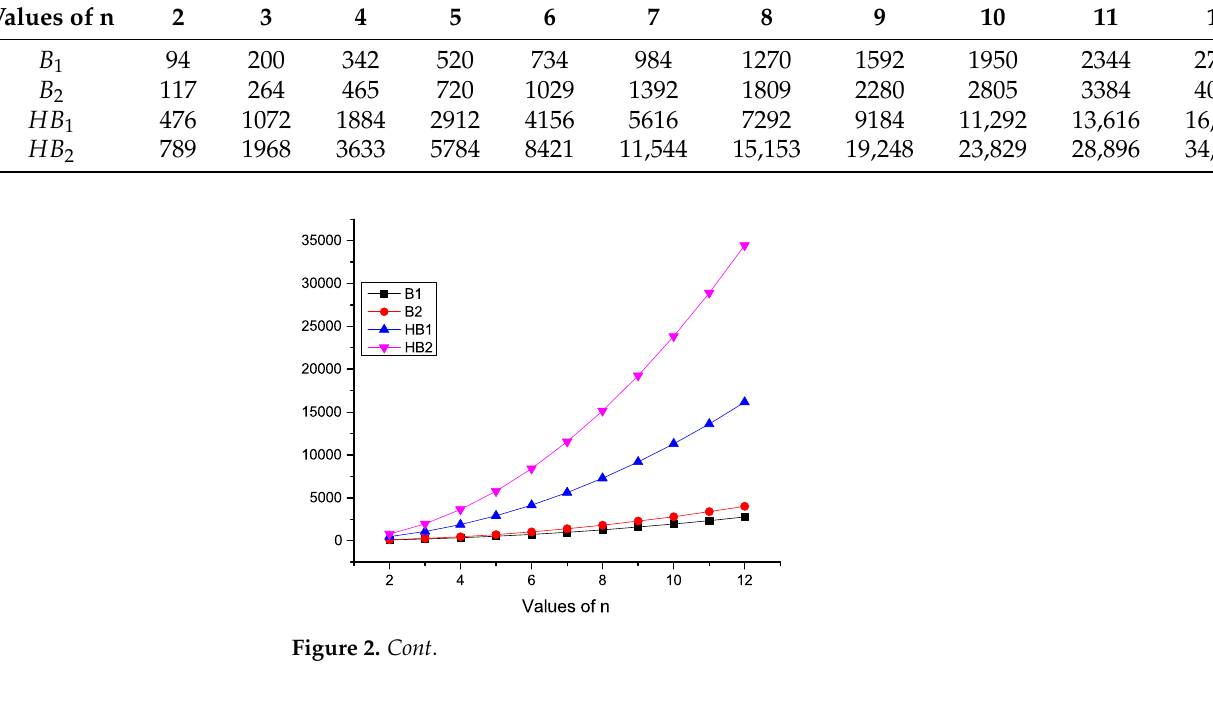
Table 2. Numerical values of K -Banhatti indices of PY n .